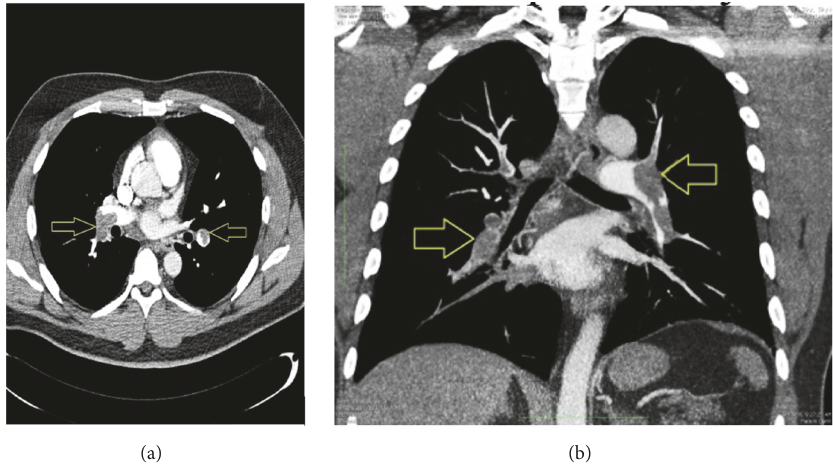
Figure 2: (a) CT pulmonary angiogram axial image showing a large filling defect in the right and left main pulmonary arteries affecting supply to both lobes of the lungs (see arrows). (b) CT pulmonary angiogram coronal view depicting large filling defects in the right and left main pulmonary arteries and bilateral lobar pulmonary arteries with bilateral lower lobe pulmonary atelectasis (see